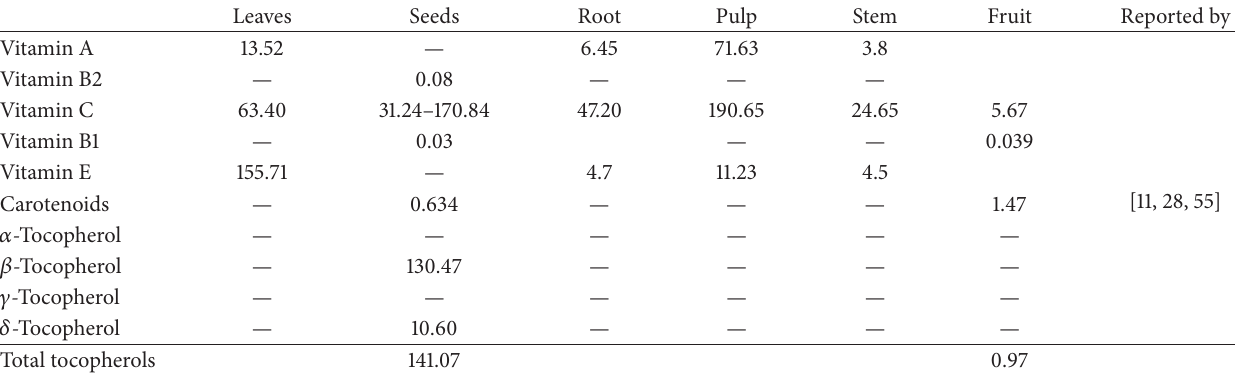
Table 4: Distribution and contents of vitamins in the different parts of Z. lotus . Vitamin contents are expressed as mg/100 g. Leaves Seeds Root